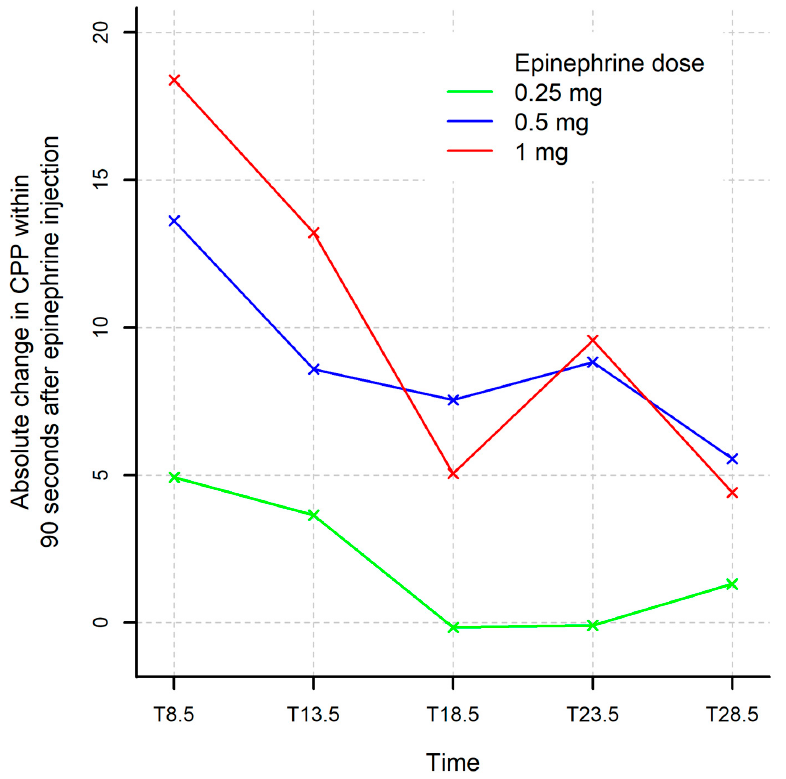
Figure 3. Absolute variation in CCP, 90 s after adrenaline injection in each group. Table 3. CPP threshold of 35 mmHg 90 s after adrenaline injection in the three compared groups.